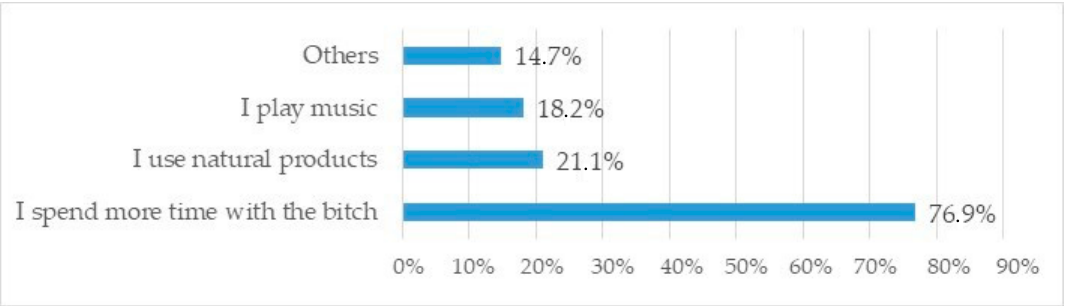
Figure 13. Methods to control anxious bitches after parturition (multiple answers allowed).